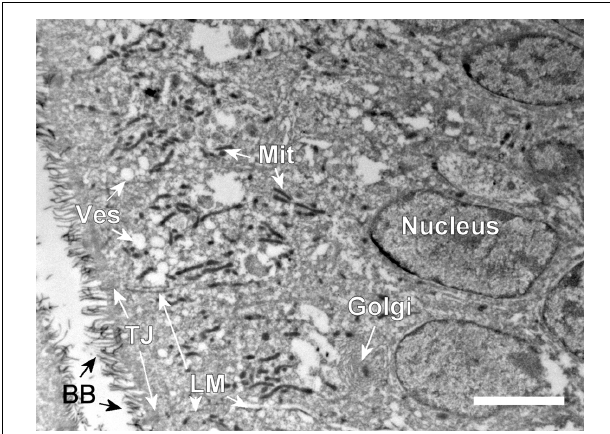
FIGURE 2 |Transmission electron micrograph from the middle intestine of SW-acclimatedAtlantic salmon. The apical brush border is seen to the left (BB).Tight junctions (TJ), lateral membrane (LM), cytoplasmic vescicles (Ves), mitochondria (Mit), nucleus, and Golgi apparatus are indicated. Size bar = 5 μ m.